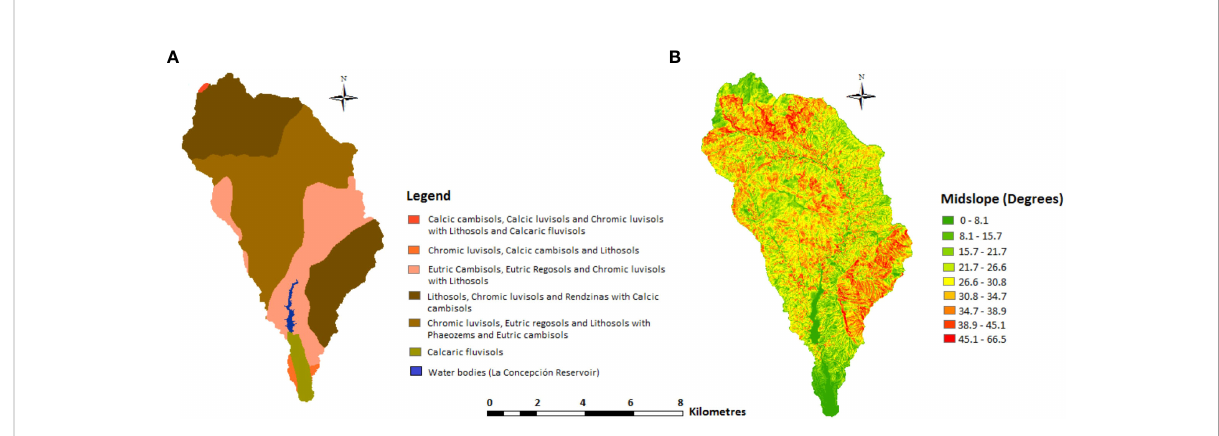
FIGURE 4 Soil categories and midslope of the river Verde basin. (A) Soil types shown following the nomenclature stated by the Food and Agriculture Organization (FAO). (B) Midslope has been calculated in degrees by using the digital elevation model (DEM) at a 25-m spatial resolution provided by the National Geographic Survey of